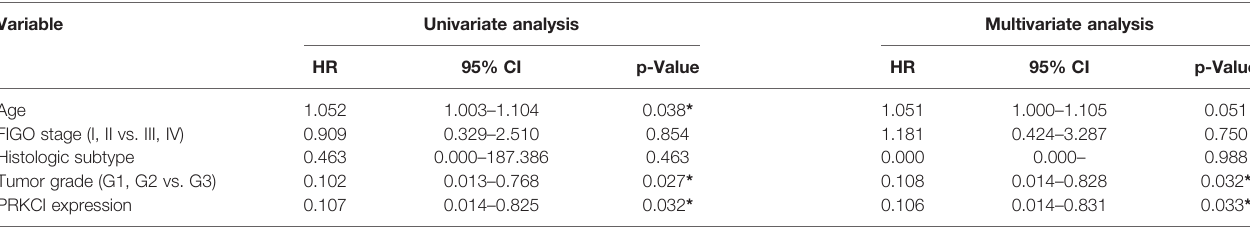
TABLE 2 | Univariate and multivariate Cox regression analyses of overall survival in CC patients who underwent radiotherapy (n = 60).